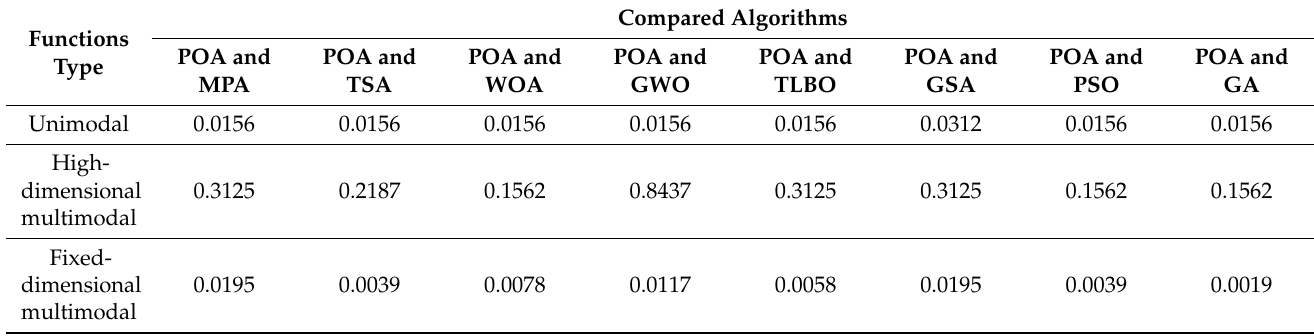
Table 5. p -values obtained from Wilcoxon sum rank test.